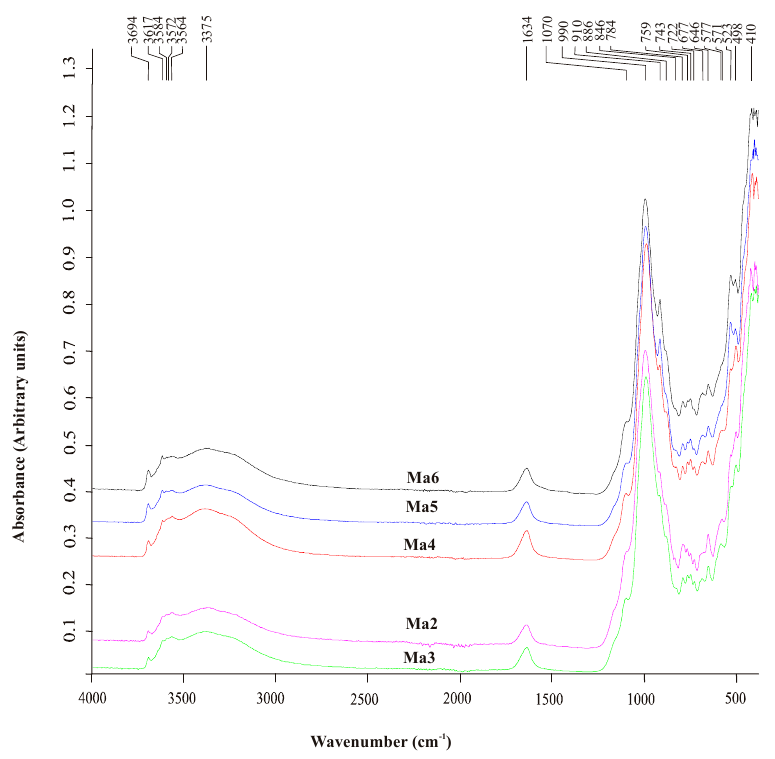
Figure 5. Infrared spectra of the studied soils from the Maroua region (Cameroon).